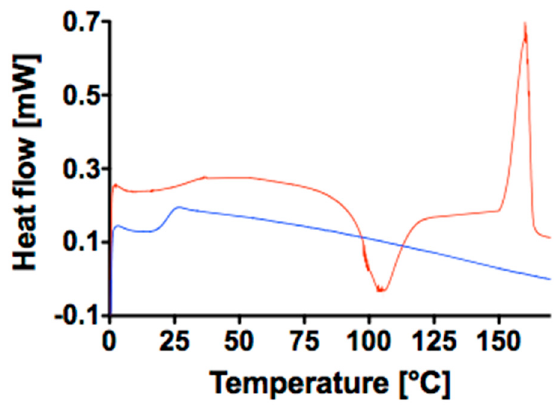
Figure 2. DSC curve of P (blue line) and E (red line).